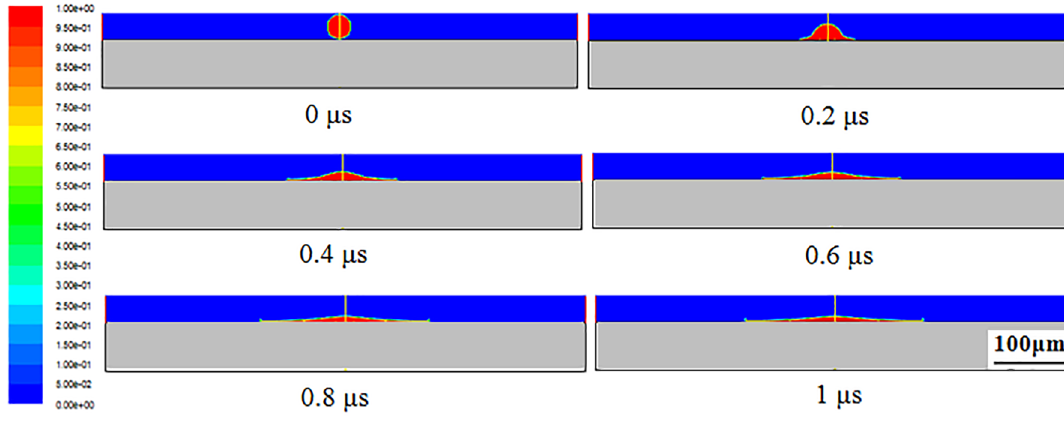
Figure 3. Deformation and solidification process of TWAS droplet (ø50 μm, 100